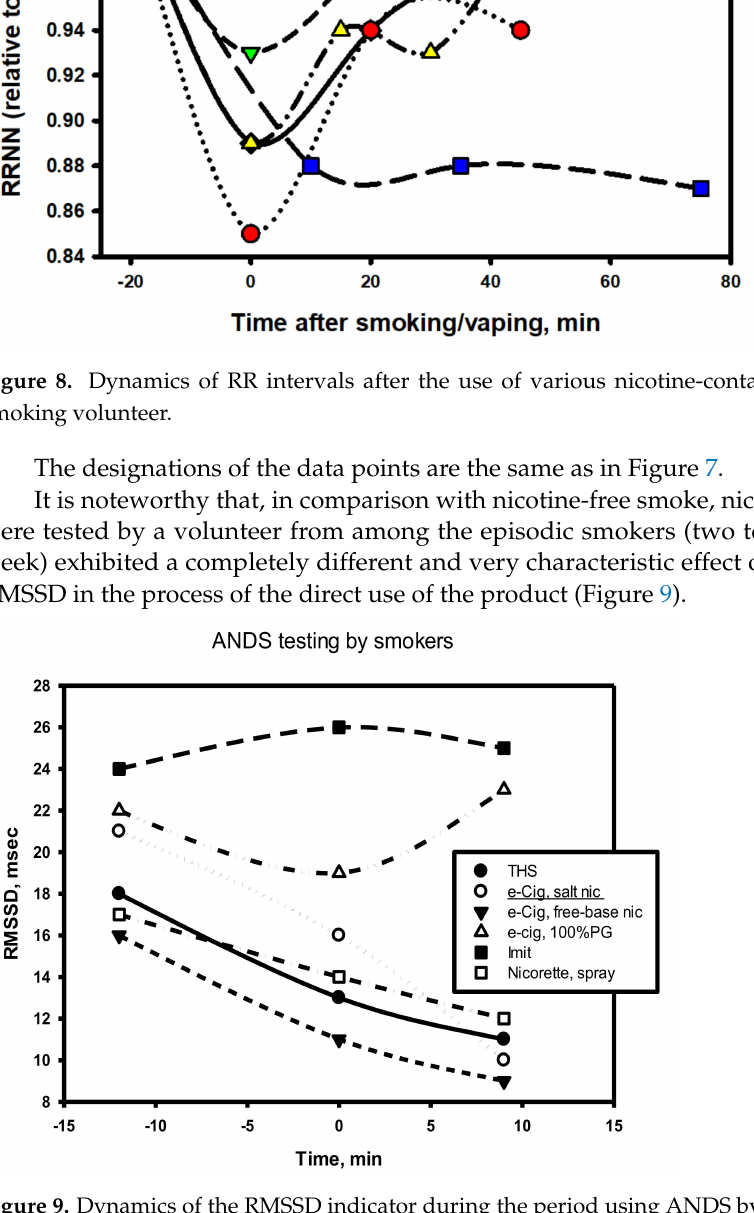
Figure 9. Dynamics of the RMSSD indicator during the period using ANDS by a smoker,